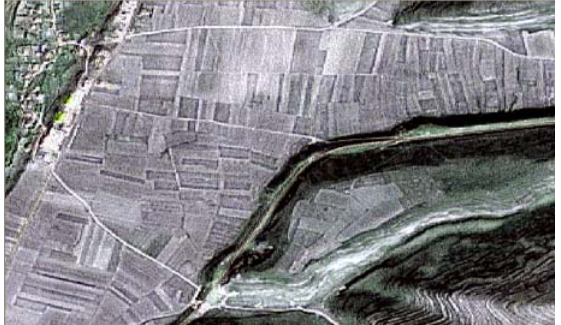
Fig.5 The original image of Classification in study area